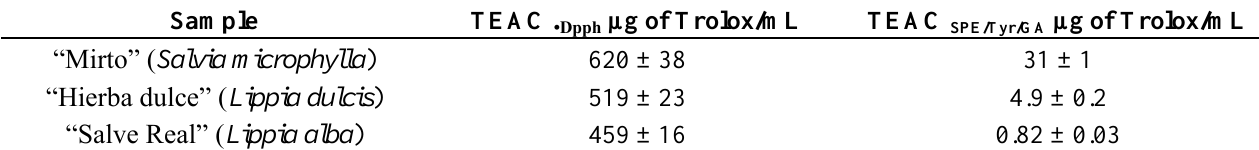
Table 3. Quantification of the trolox equivalent antioxidant capacity of different